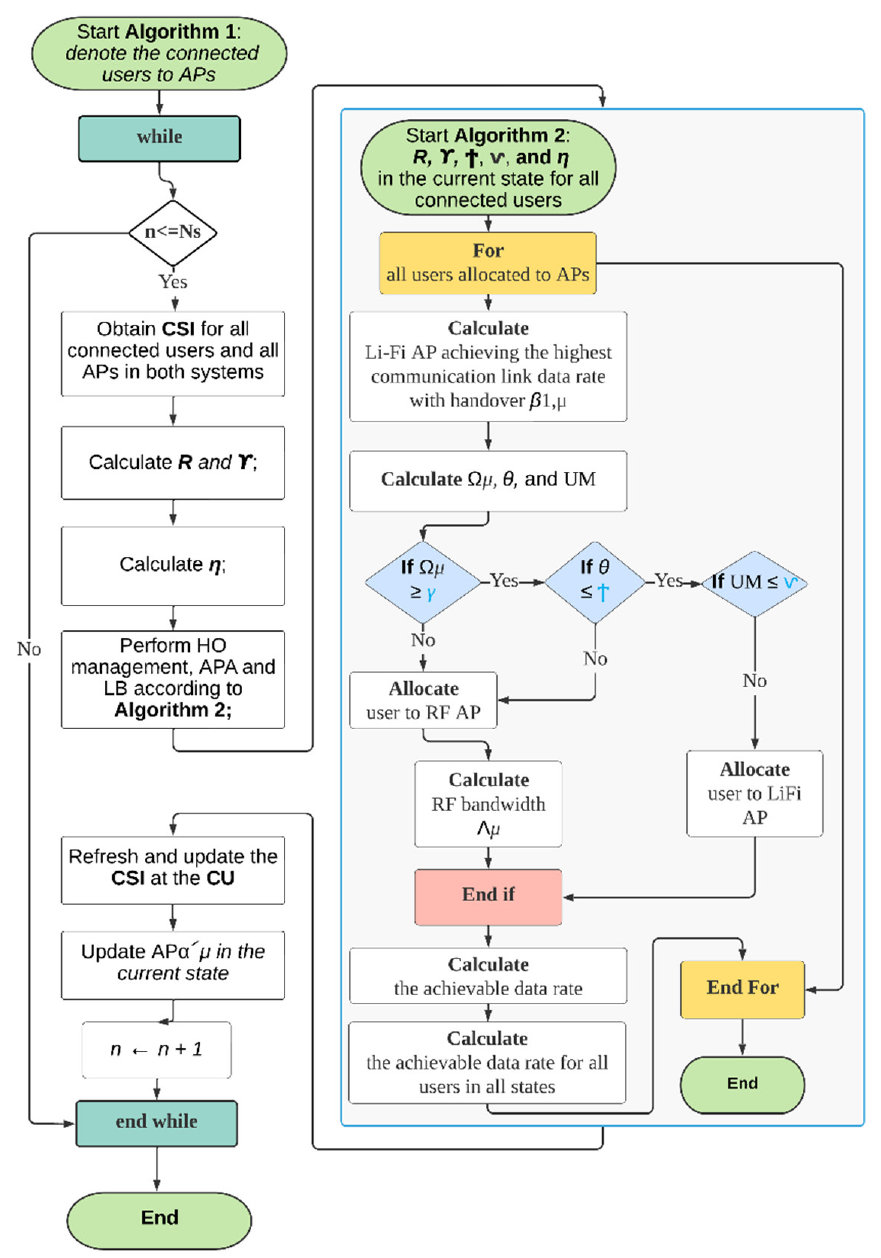
Figure 6. Algorithm Flowchart.